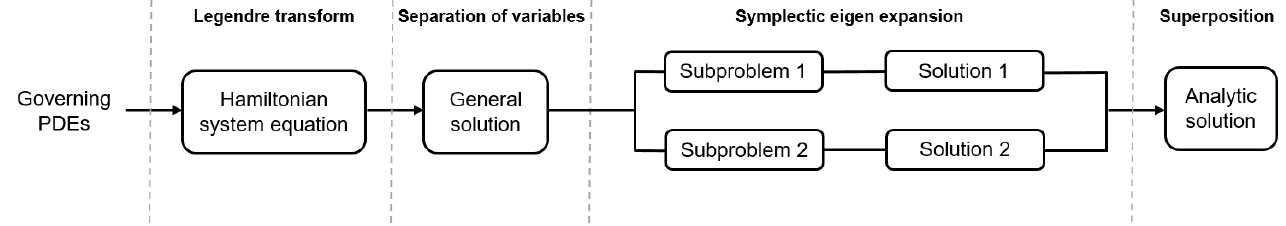
Figure 1. Schematic illustration of ( a ) a bi-layered FEH with parallel wire structures integrated with human skin and ( b ) a bi-layered transient heat conduction model.